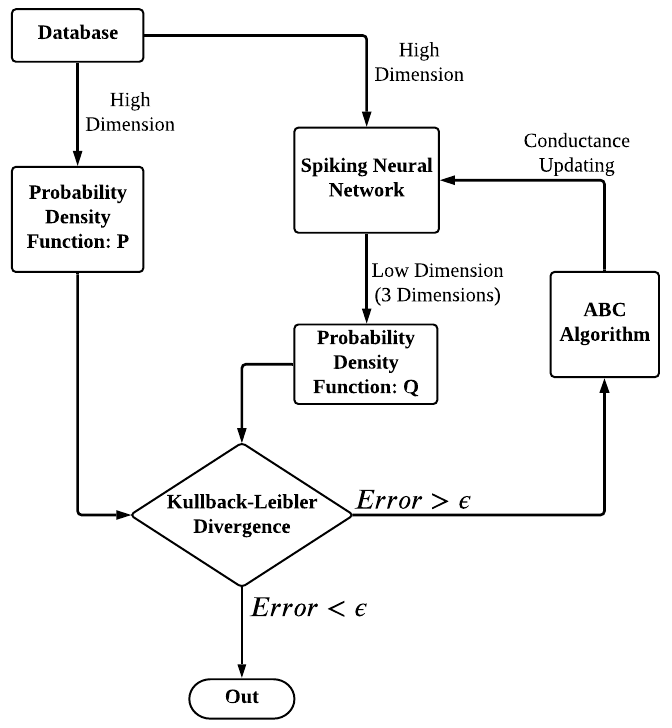
Figure 4. Training Process of the Spiking Neural